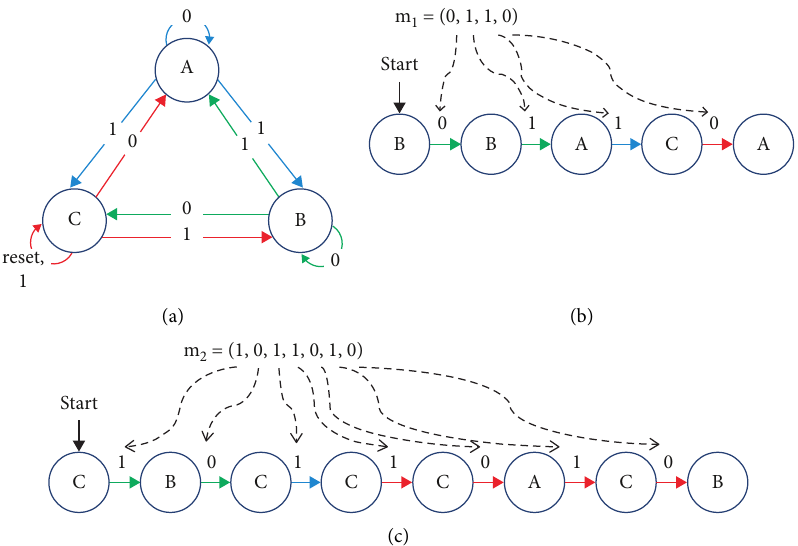
Figure 12: (a) The state chain diagram with assignments. (b) Selected path through the SC diagram of (a) for m path through the SC diagram of (a) for m